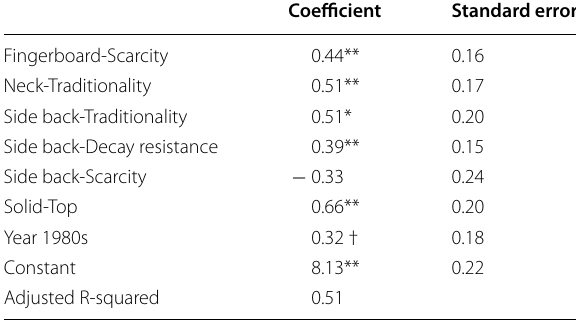
Table 6 Multiple regression analysis for Yamaha guitars